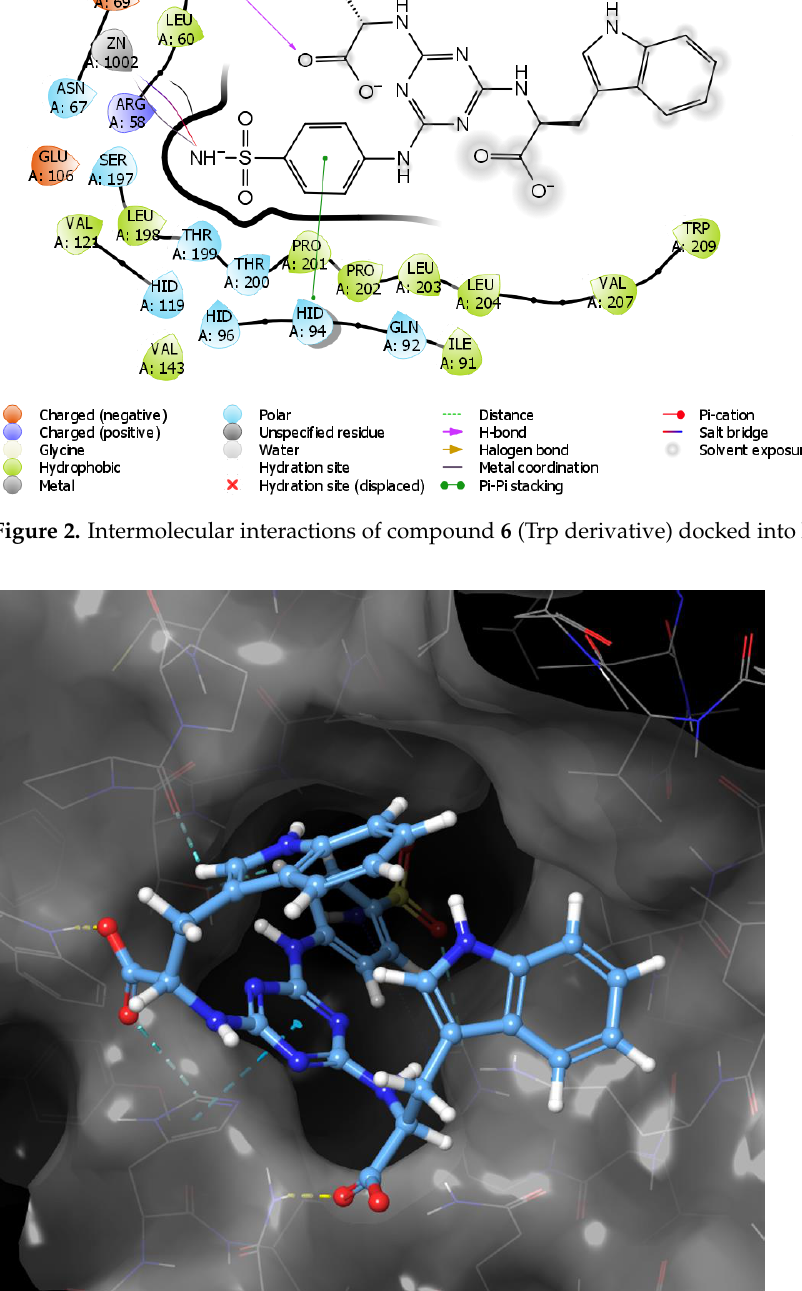
Figure 3. Molecular surface of the binding site of hCA IX with docked compound 6 (Trp derivative).